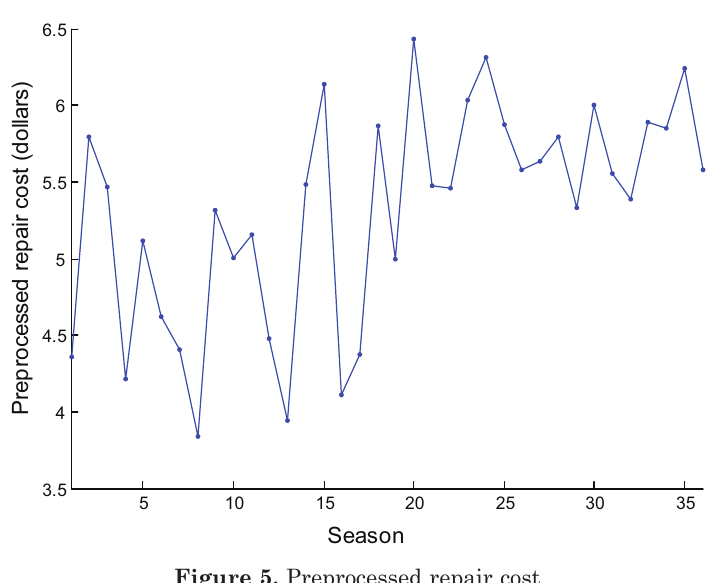
figure 5. Preprocessed repair